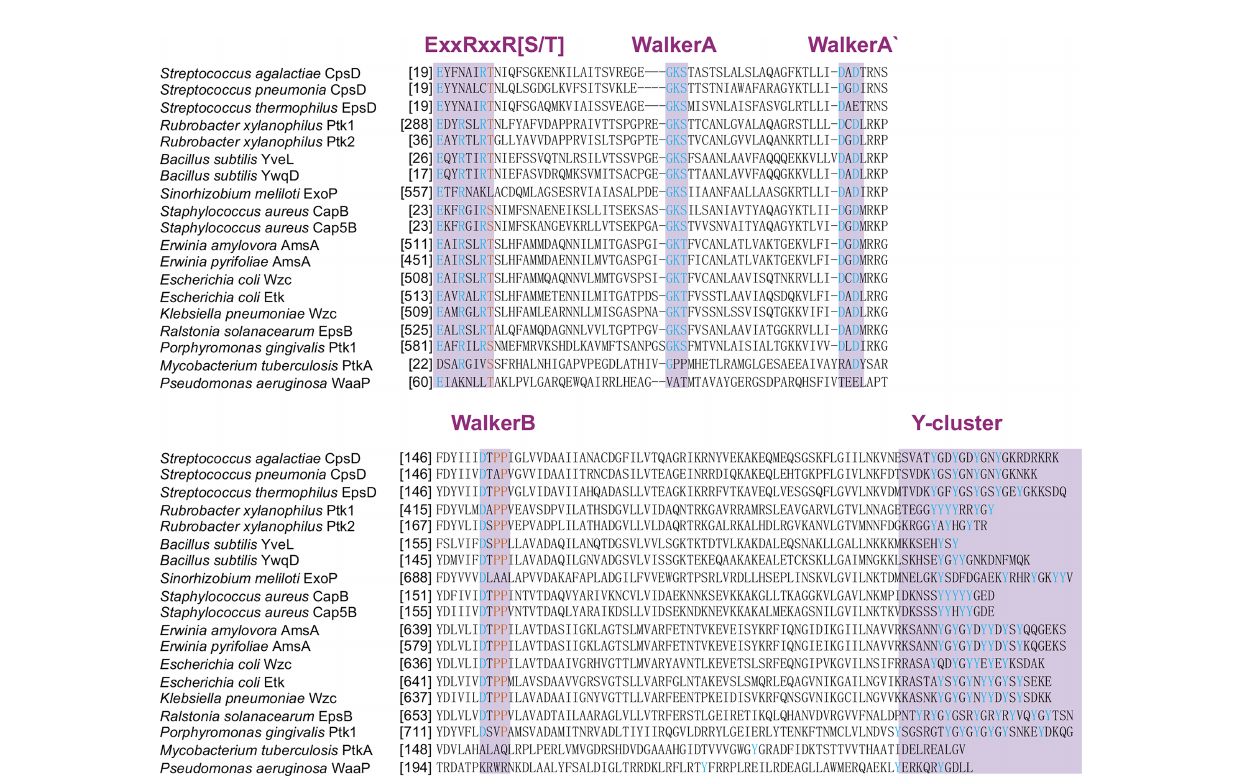
FIGURE 1 | The active motif of BY kinase. Conservative ExxRxxR motif, canonical Walker A motif (GxxxxGK[S/T]), Walker B motif ([ilvfm](3)DxDxR), and a tyrosine- rich cluster (Y cluster) at the C-terminal sites are common features of the BY kinase from 19